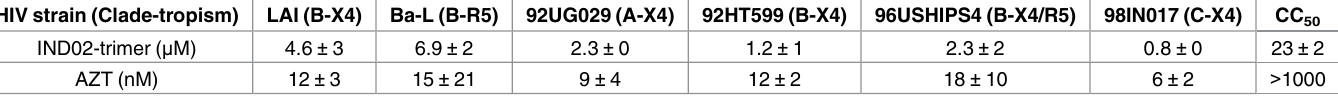
The table shows the effective concentration, EC 50 (mean of a triplicate determination ± SD in μ M) required to inhibit 50% of various HIV-1 stains replication incubated at 125 TCID 50 with 150 000 PBMCs. The cytotoxic concentration, CC 50 (mean of a triplicate determination ± SD in μ M) of the IND02-trimer and AZT that cause death to 50% of the viable cells is also shown in the